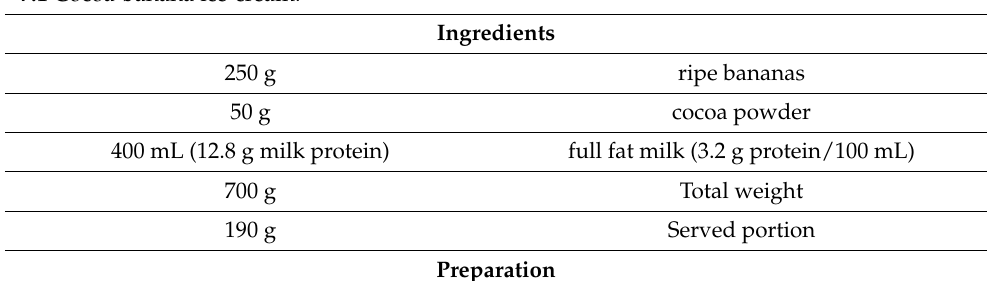
Table 1. Cont. 7.1 Cocoa-banana